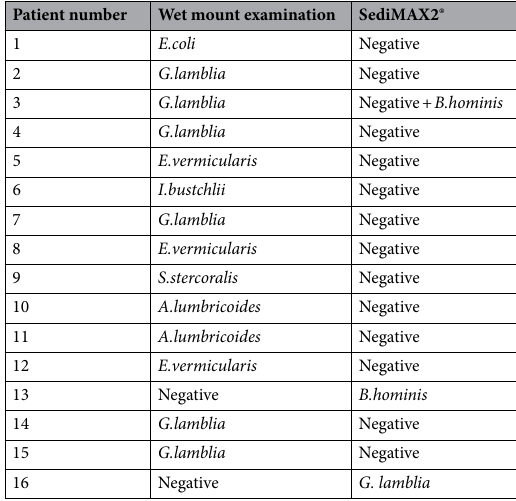
Table 1. Discordant results between SediMAX2® and wet mount